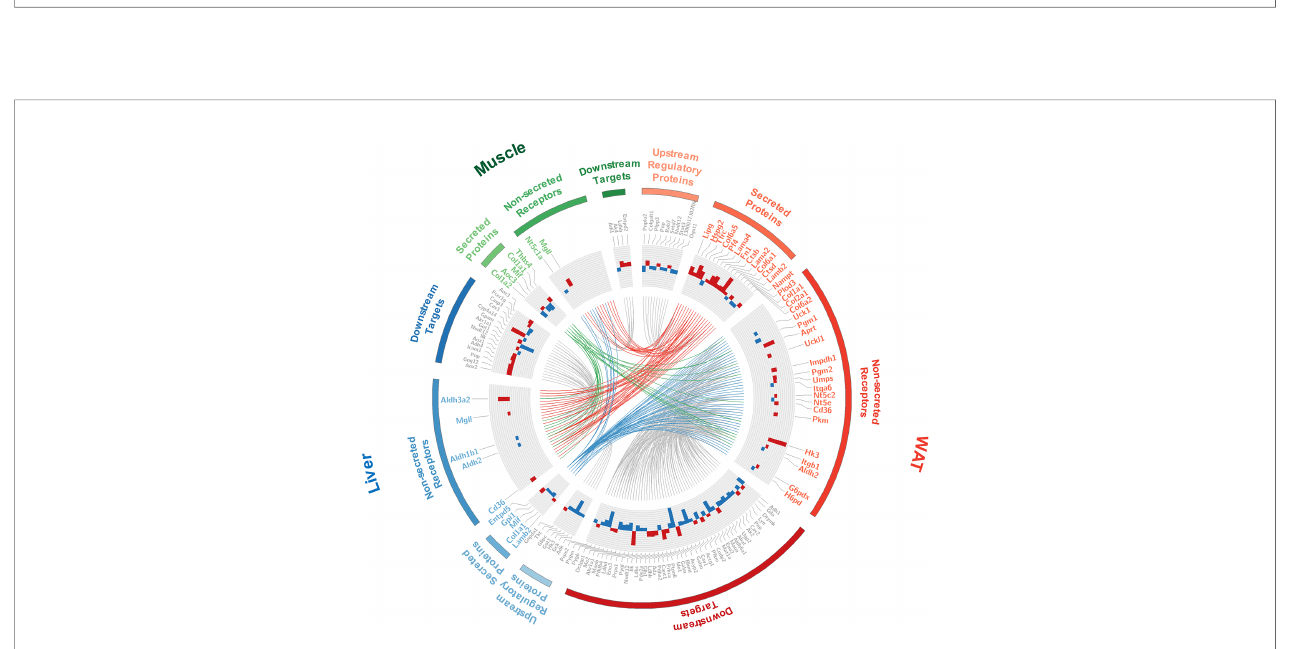
FIGURE 6 | Detailed information of the tissue crosstalk interface relevant to IR. Where, fold changes of all differential proteins were shown in bar plots; the differentially expressed secretory proteins and their differential non-secreted receptors were labeled in color corresponding to each tissue; the up- and down-stream regulators were labeled in gray; the cross-tissue interactions started from WAT, liver, and skeletal muscle were respectively colored in red, blue and green.